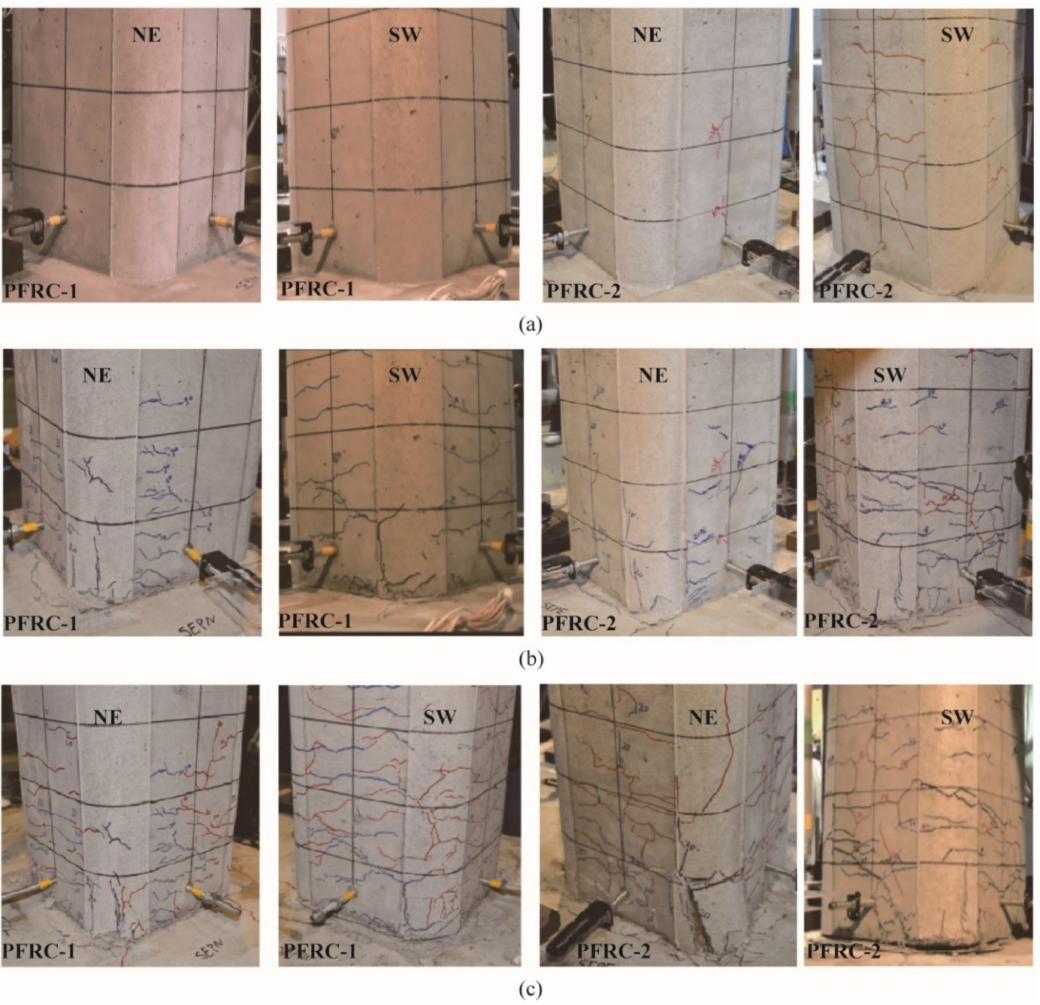
Figure 4. Damage development at the column base in PFRC-1 and PFRC-2. ( a ) After 1st excitation, ( b ) After 2nd excitation, ( c ) After 3rd